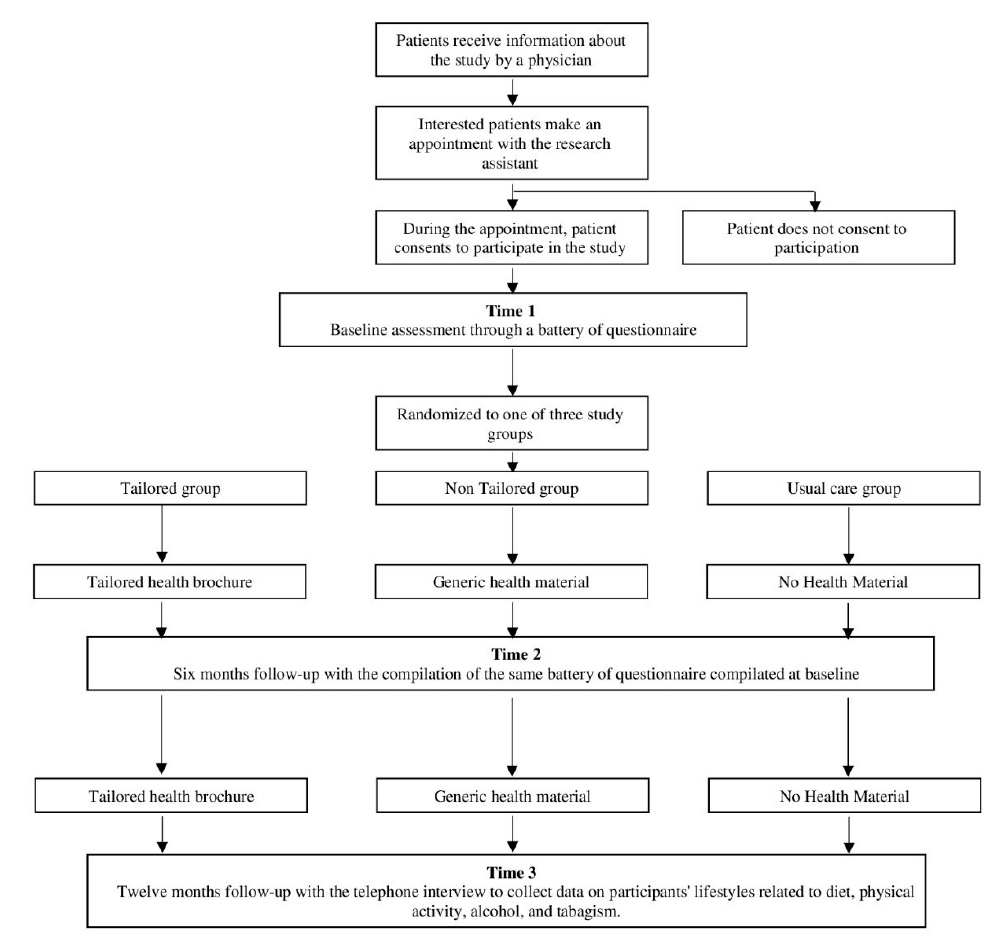
Figure 1. Flowchart of study participation.